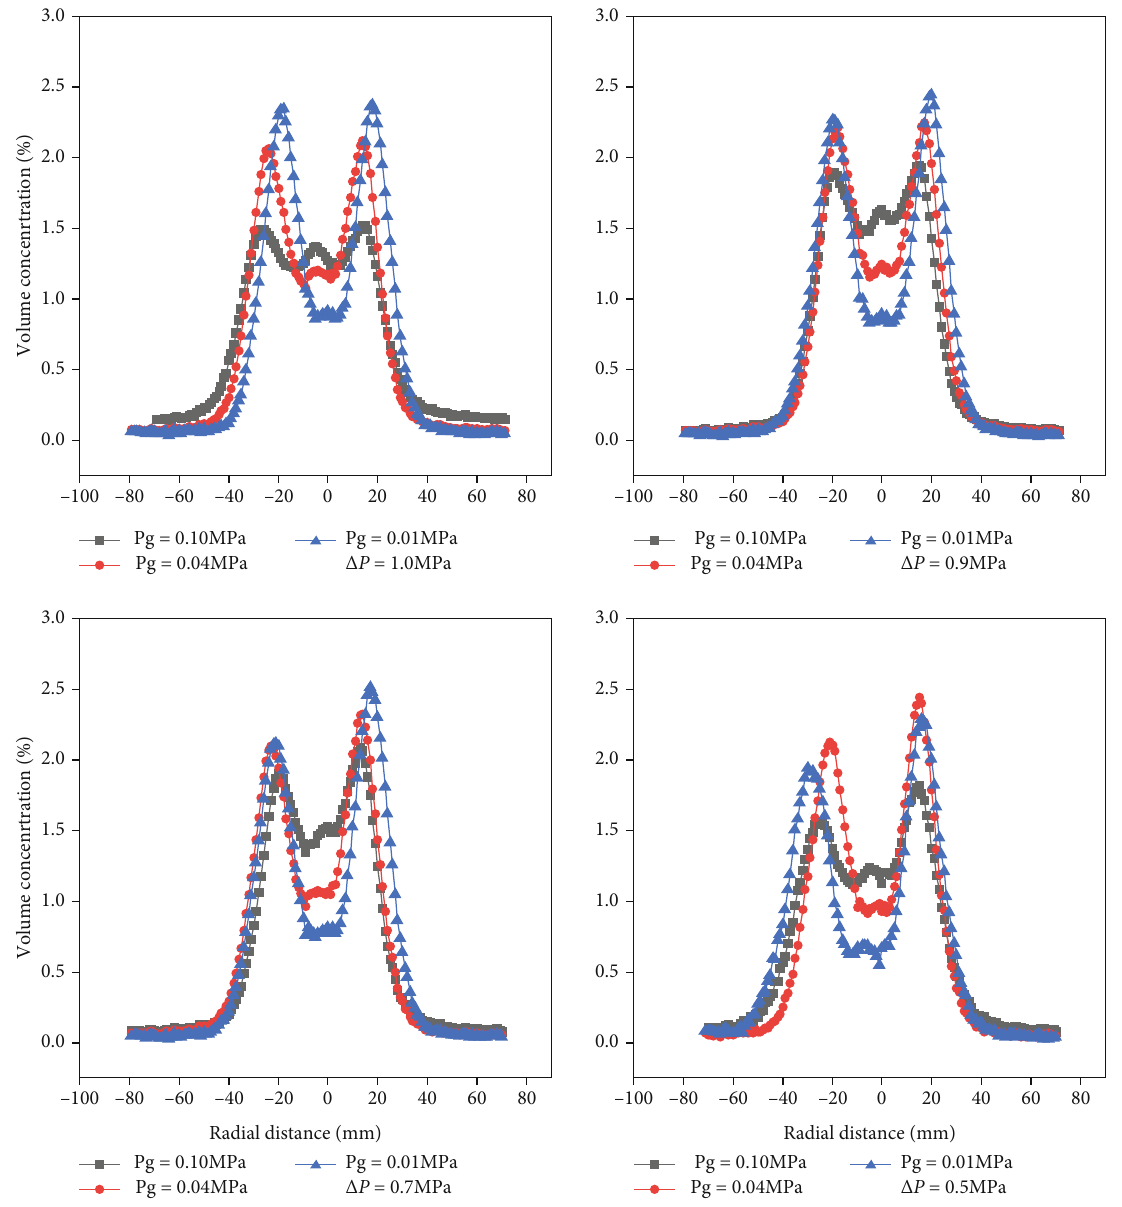
Figure 7: Distributions of dimensionless fuel volume